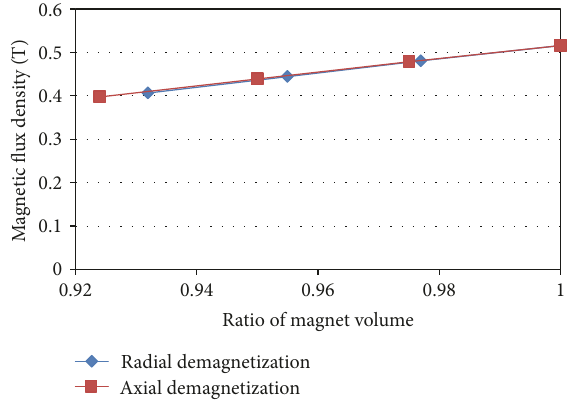
Figure 8: Calculated magnetic flux density at the center point of air- gap and axial direction for ratio of PM